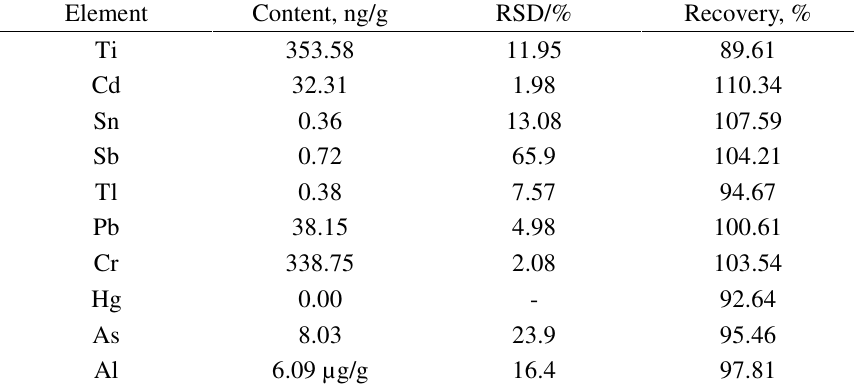
Table 5. Contents and relative standard deviations of rare earth elements